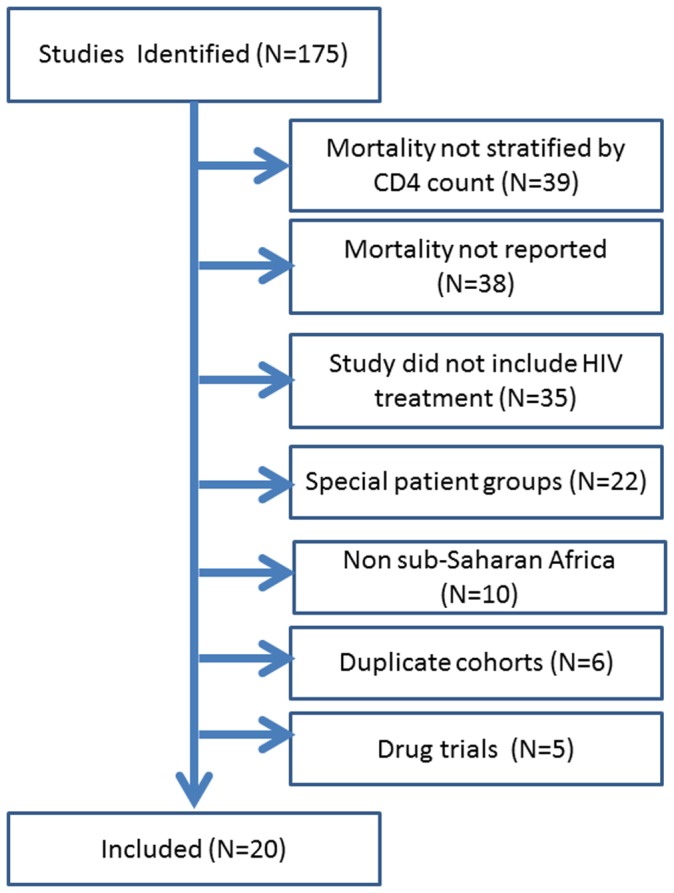
Flowchart of identified studies, included studies and reasons for exclusion.